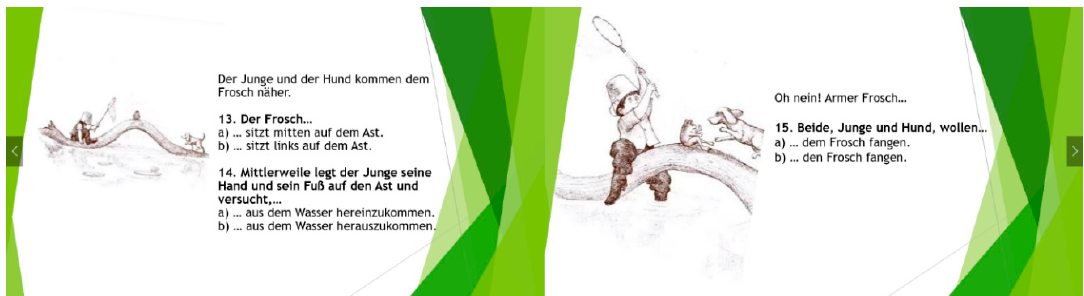
Figure A18. Pretest: Binary-choice recognition task.